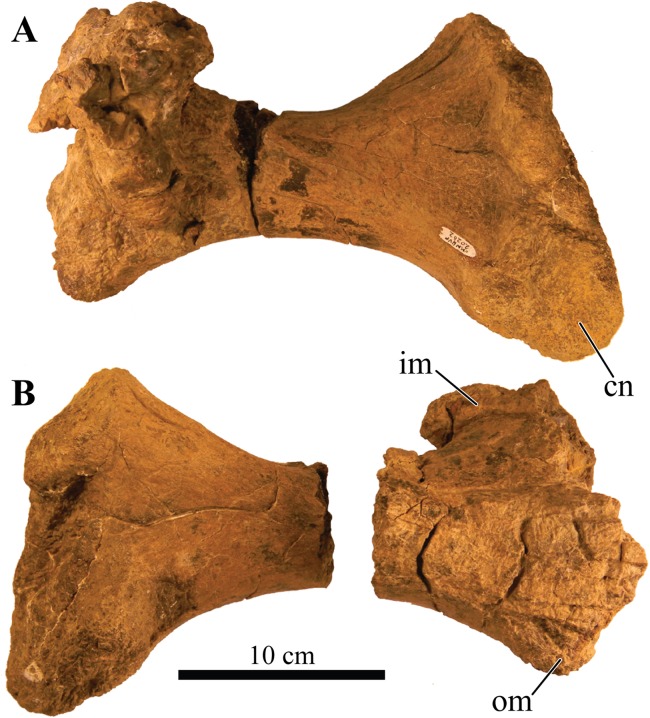
Right tibia.Photographs of the right tibia of Akainacephalus johnsoni (UMNH VP 20202) in (A), anterior; and (B), posterior views. Study sites: cn, cnemial crest; im, inner malleolus; om, outer malleolus.